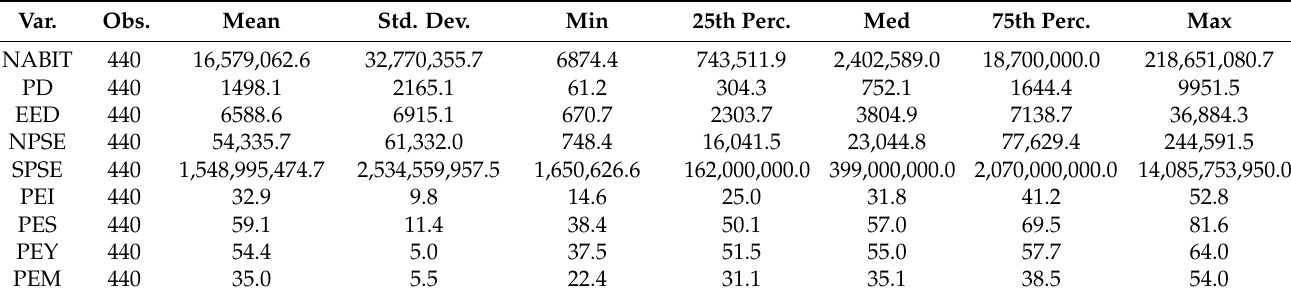
Table 2. Summary of the descriptive